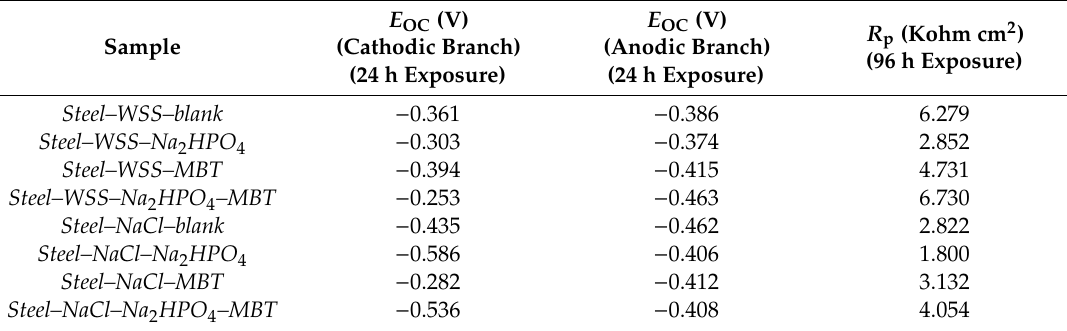
Table 4. Tabulated values of E OC [V vs. Ag / AgCl,KCl (sat) ] obtained from the potentiodynamic polarization (PP) technique and of R p estimated via the linear polarization resistance (LPR) method acquired for all mild steel panels after subjection in either WSS or 3.5 wt % NaCl in the presence of inhibitors or